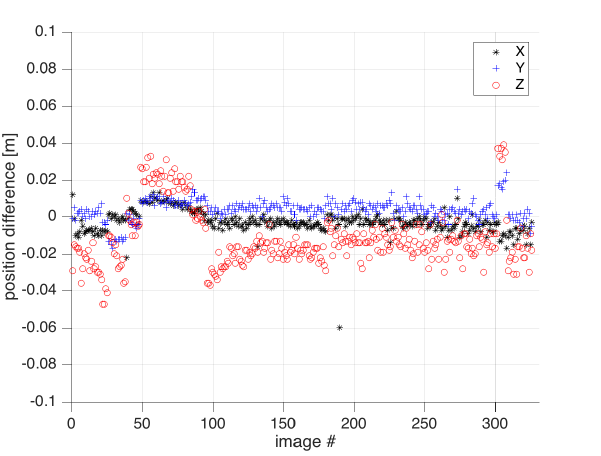
Figure 6. Differences in absolute camera positions between high- end and low-cost L1 only (ambig.-fixed) GNSS